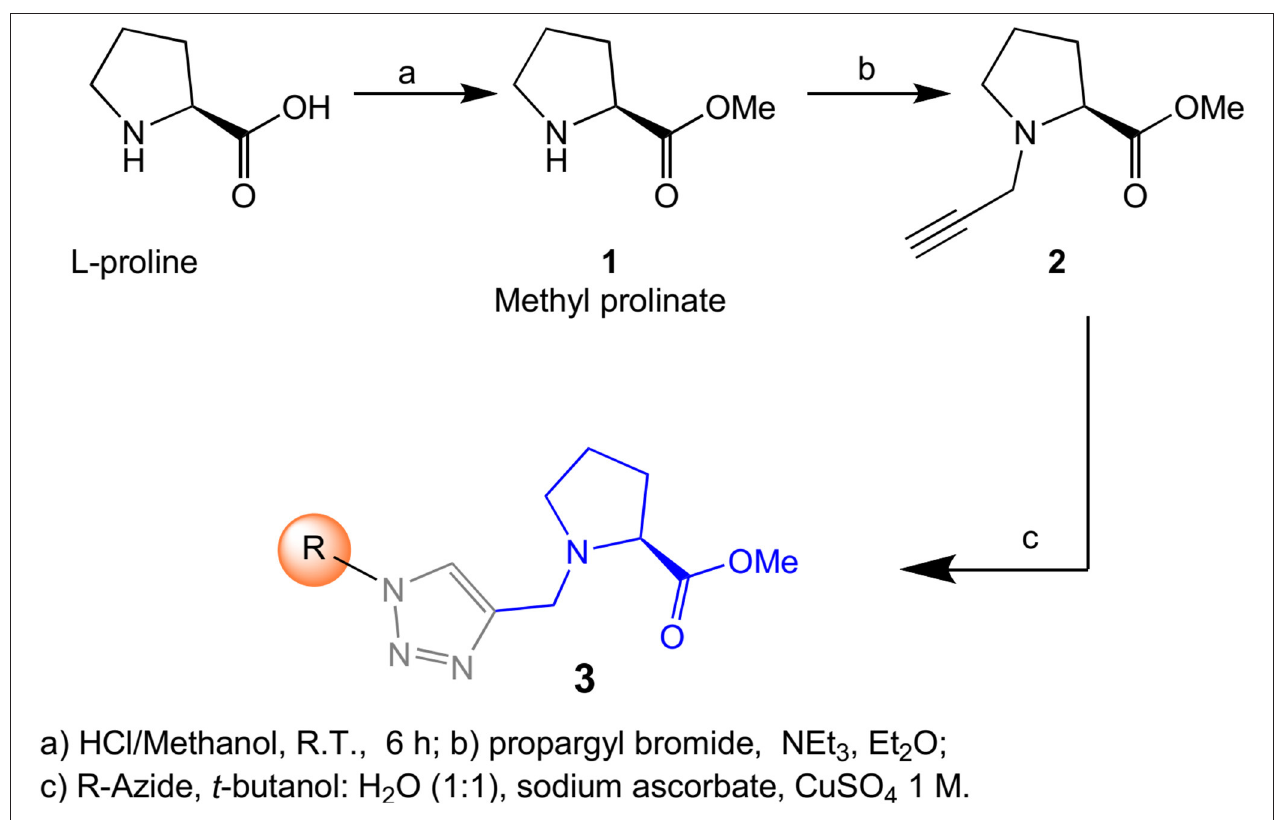
SCHEME 1 | Synthesis of proline transport inhibitors.